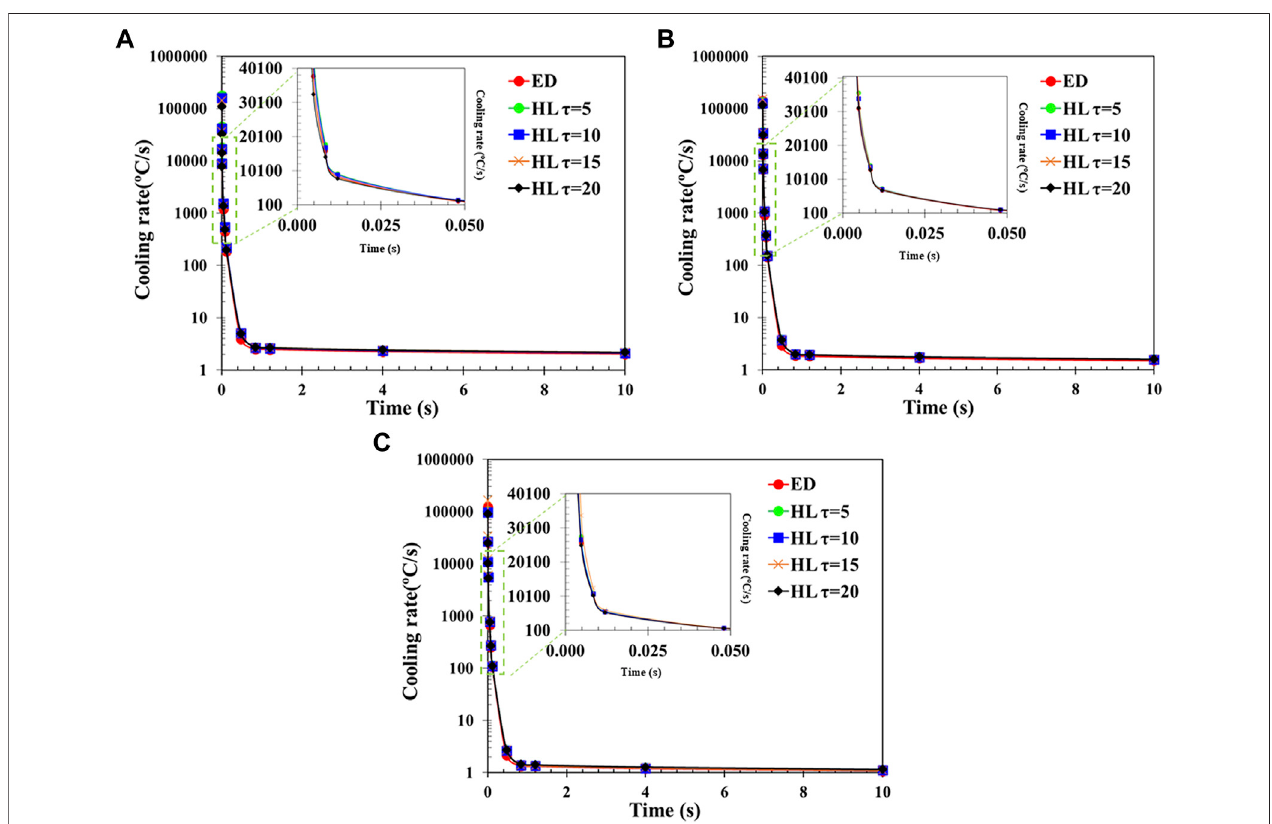
FIGURE 13 | Cooling rate pro fi les for the following laser powers and speeds: (A) 220 W – 800 mm/s (B) 200 W – 1,000 mm/s, and (C) 180 W – 1,300 mm/s.